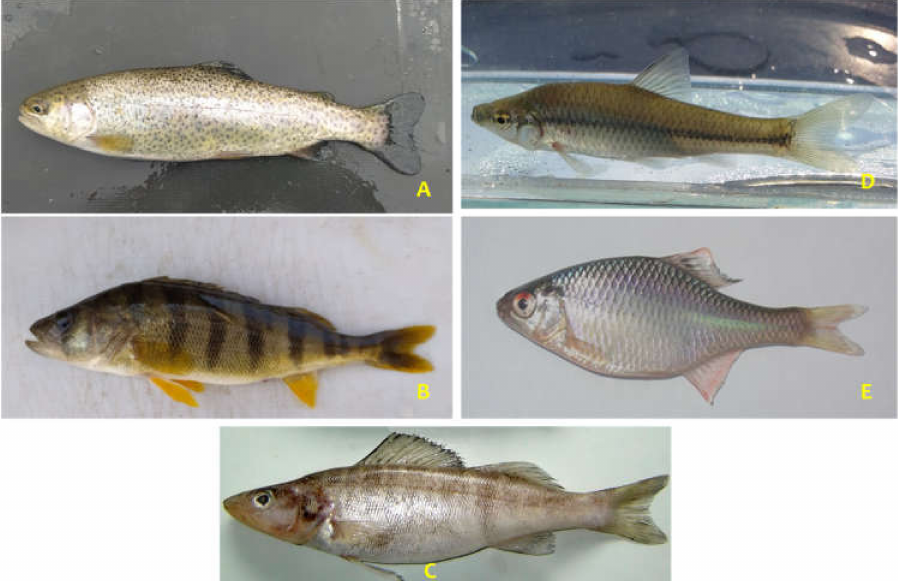
Figure 5. Alien species recorded in the River Black Drini survey locations. ( A ) Onchorhyncis mykiss ; ( B ) Perca fluviatilis ; ( C ) Sander luciperca ; ( D ) Pseudorasbora parva and ( E ) Rhodeus amarus . Table 2. Conservation status of fish in the Black Drini River. Threat Status IUCN Red List Albanian Red List Critically Endangered (CR) 1 - Endangered (EN) - - Vulnerable (VU) 4 2 -